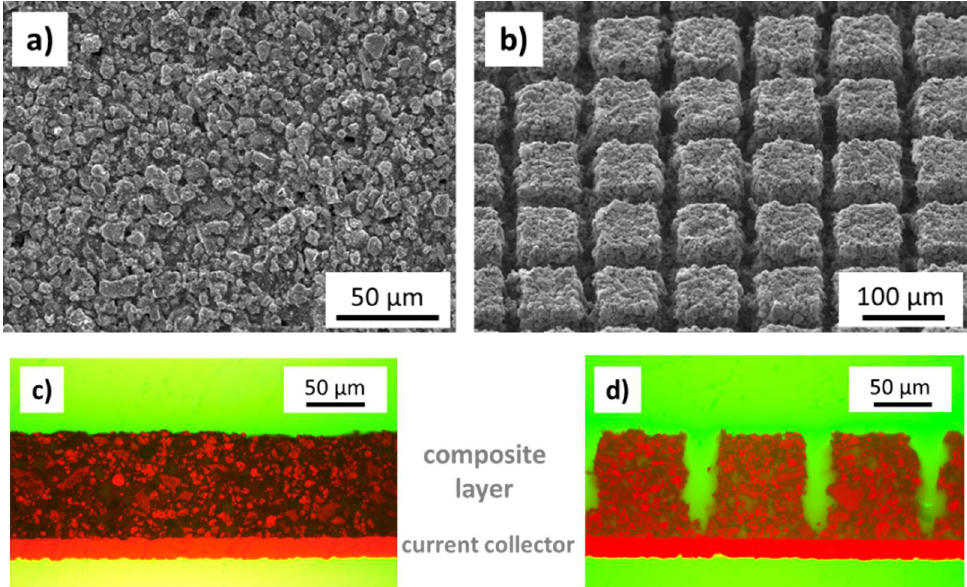
Figure 2. Lithium-ion battery cathode samples—( a , b ) unstructured and ( b , d ) structured—based on